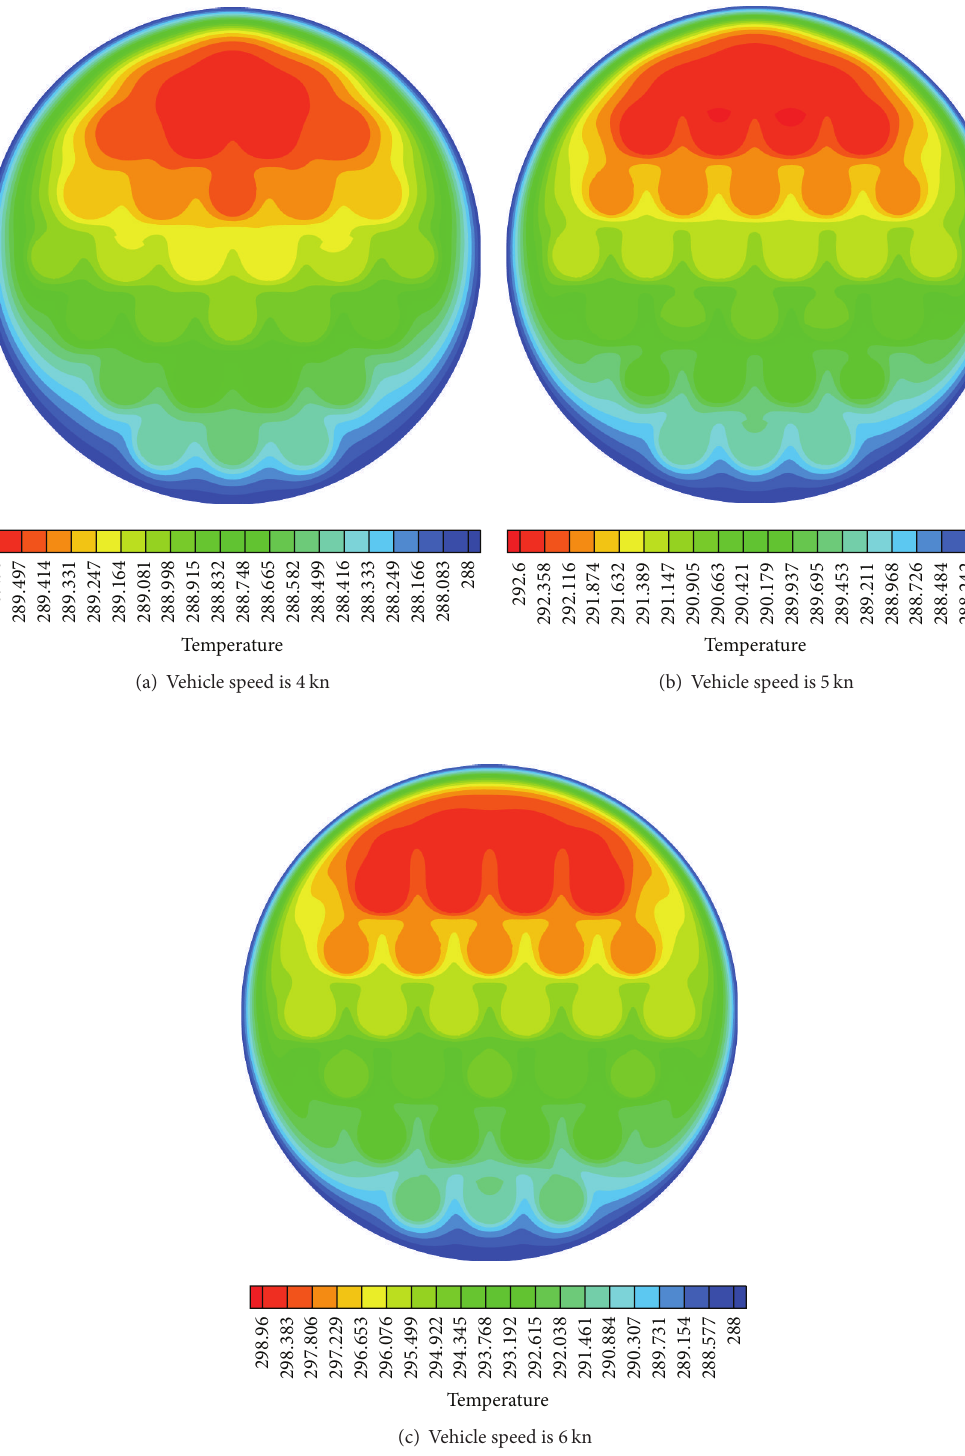
Figure 8: Battery compartment internal temperature profile at different